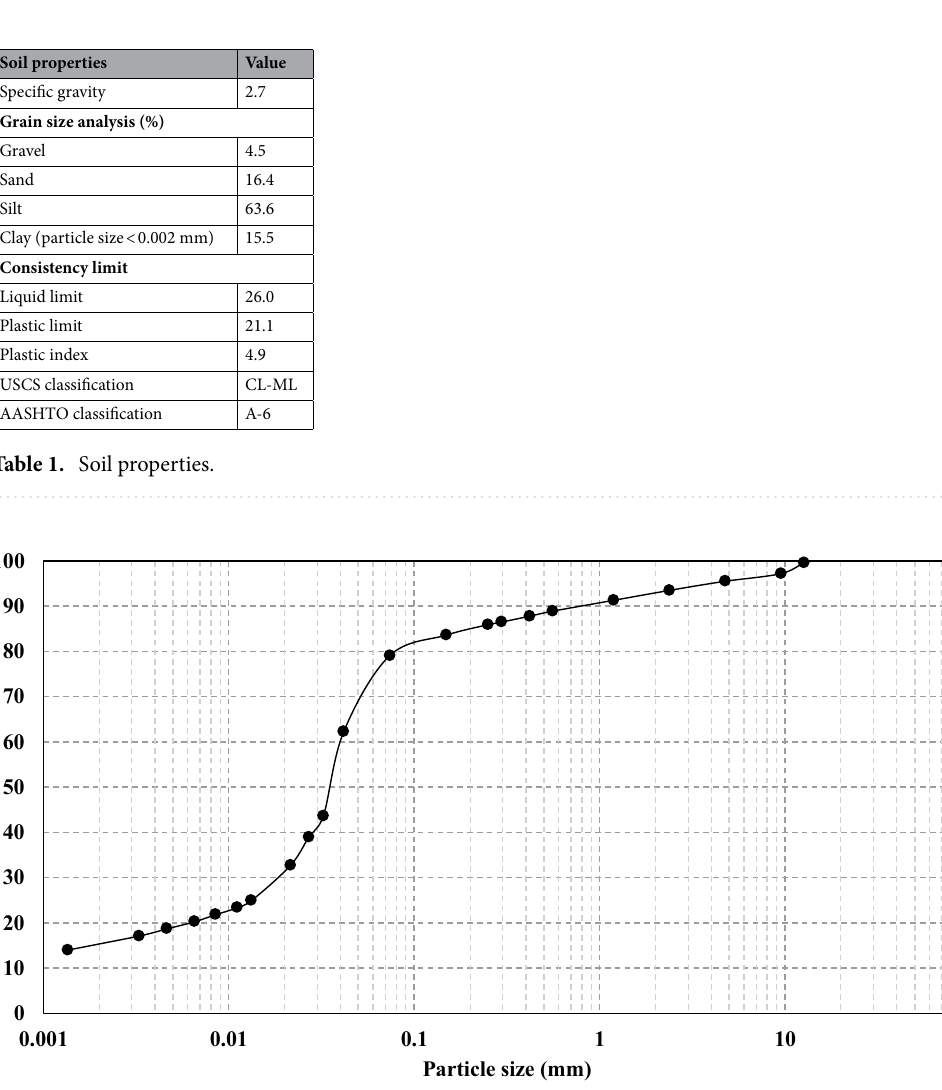
Figure 1. Soil grain size